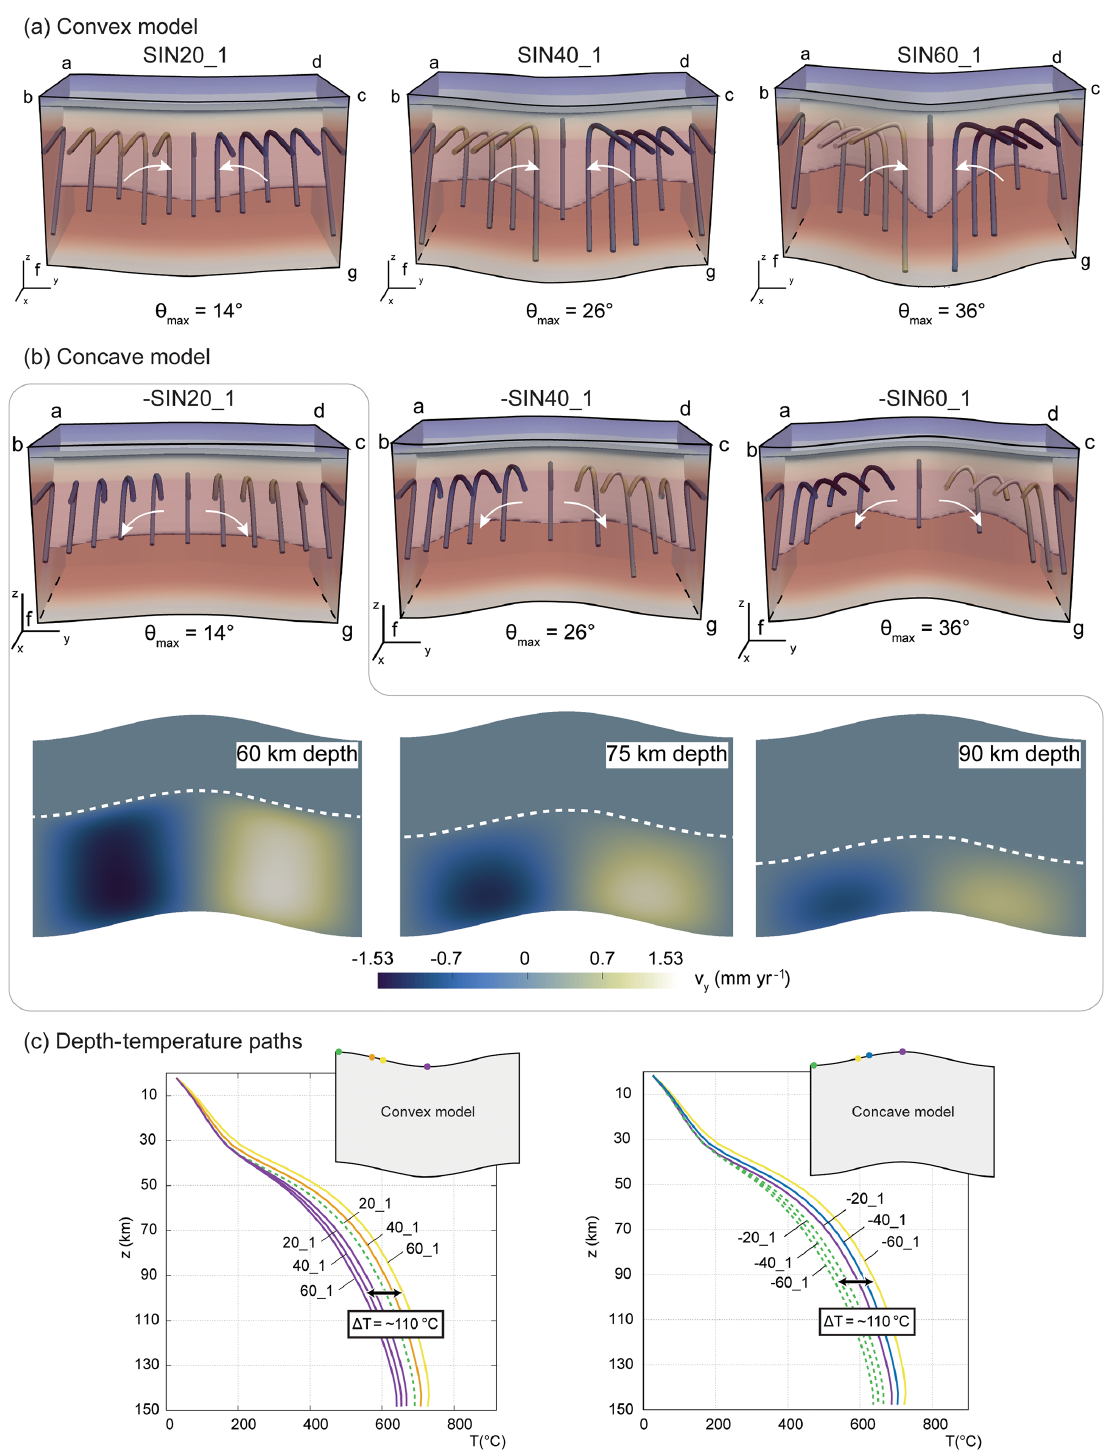
Figure 5. (a) Mantle flow, shape of the 450 ◦ C isotherm for the convex models (SIN20_1, SIN40_1 and SIN60_1). (b) Mantle flow, shape of the 450 ◦ C isotherm for the concave models (SIN20_1, SIN40_1 and SIN60_1). Velocity maps of the y component are reported at 60, 75 and 90km depths for the case − SIN20_1. (c) Summary of the depth–temperature path calculated for the convex and concave models, showing a maximum temperature variation of ca. 110 ◦ C with the most oblique models. Details on (cid:49)T 75km are given in Table 2.